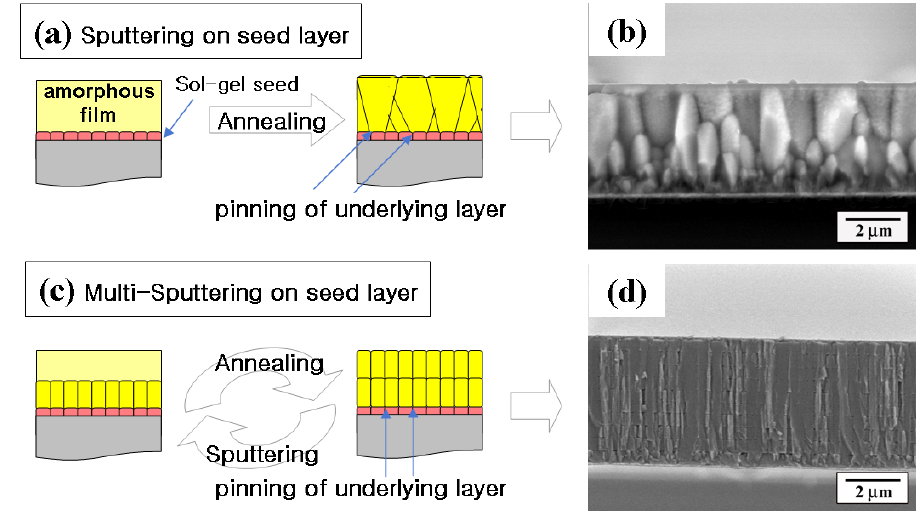
Figure 7. Sputtering method with seed layer to control the grain growth. (a) schematic diagrams of normal sputtering on a seed layer, (b) cross-sectional view of 3.5 μ m-thick film using normal sputtering on a seed layer [42], (c) schematic of multi-sputtering on a seed layer, and (d) cross-sectional view of 5 μ m-thick film using multi-sputtering on a seed layer